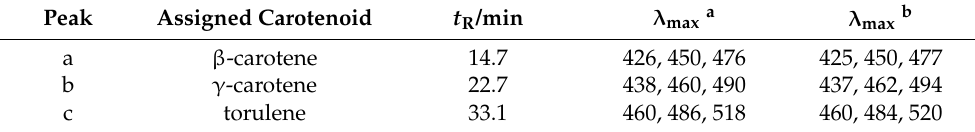
Table 5. Optimum levels and contribution of factors and expected results for the validation trial. Peak